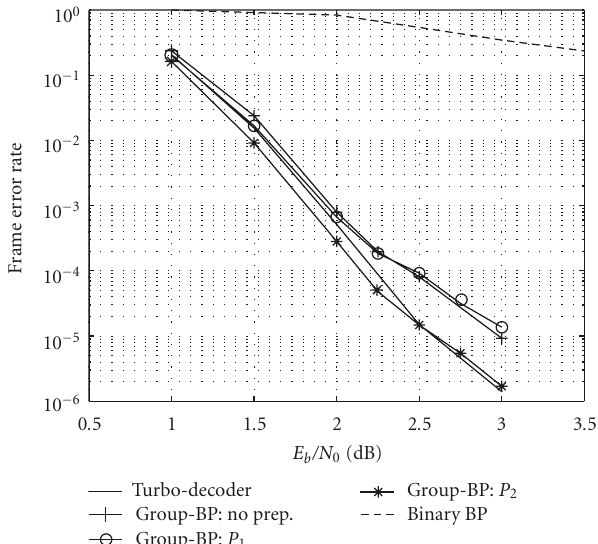
Figure 5: Performance of the group BP decoding algorithm based on di ff erent preprocessing functions for the ( R = 0 . 5, N = 848) duobinary turbo code and comparison with the turbo decoder as used in the DVB standard.